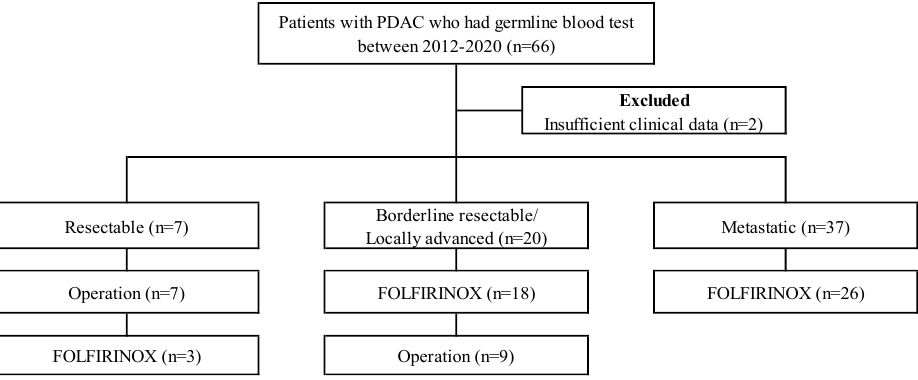
Figure 1. Selection of study population with PDAC, pancreatic ductal adenocarcinoma; FOLFIRINOX: oxaliplatin, irinotecan, folinic acid, and fluorouracil. Table 1. Baseline characteristics of patients who had germline genetic blood